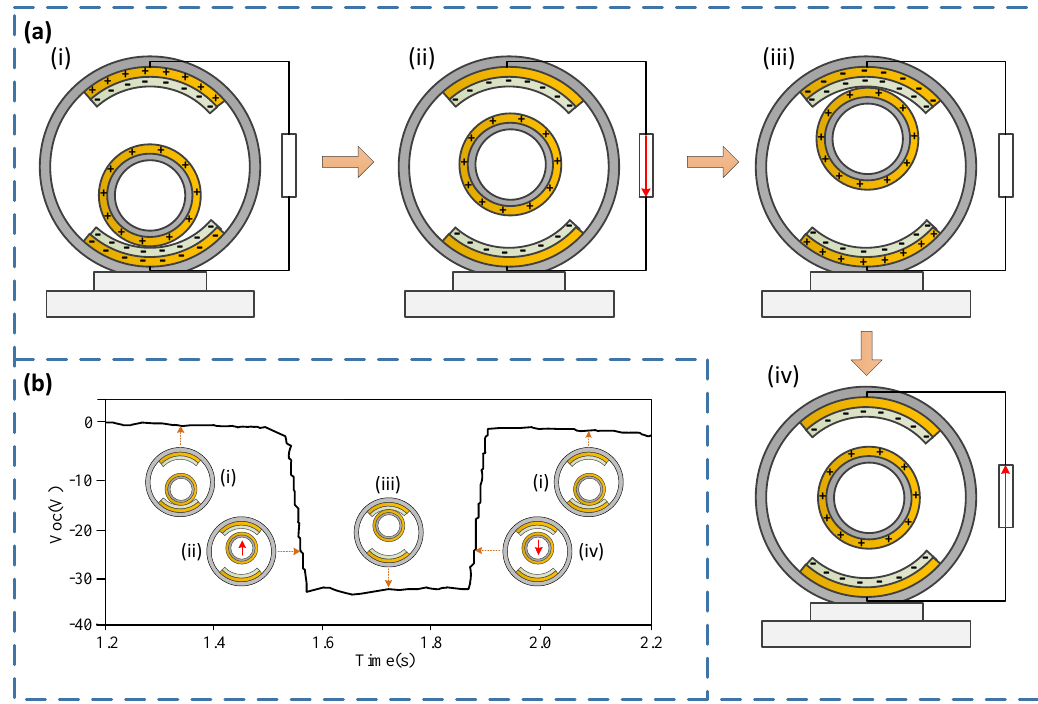
Figure 3. Schematic diagram of the working process of the S-TENG. ( a ) Schematic diagram of the charge transfer rule in the working process of the S-TENG; ( b ) Theoretical output voltage signal of the S-TENG.